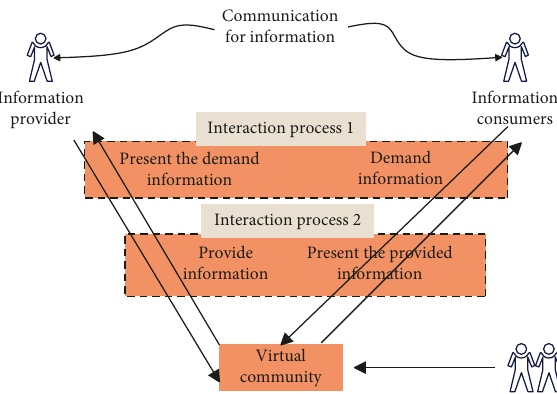
Figure 5: Information dissemination process in virtual community of English translation online teaching.